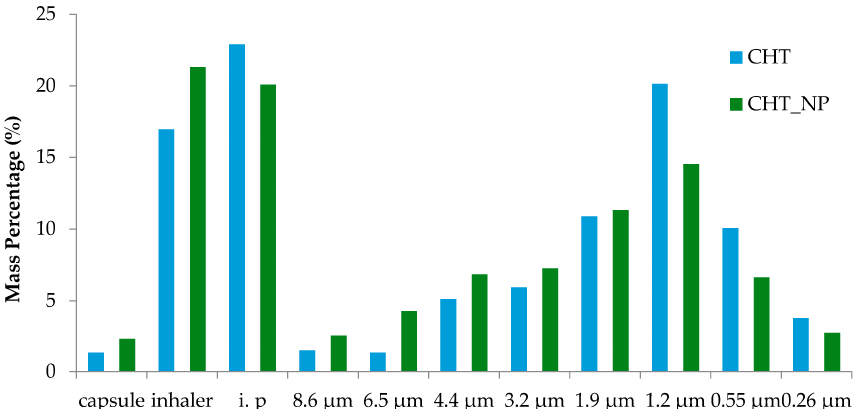
Figure 7. Percentage of mass powder entrapped in the different stages of the ACI. The ACI experiment was performed in a Coppley Scientific instrument at 60 L/min and four kPa. I.p stands for the induction port.